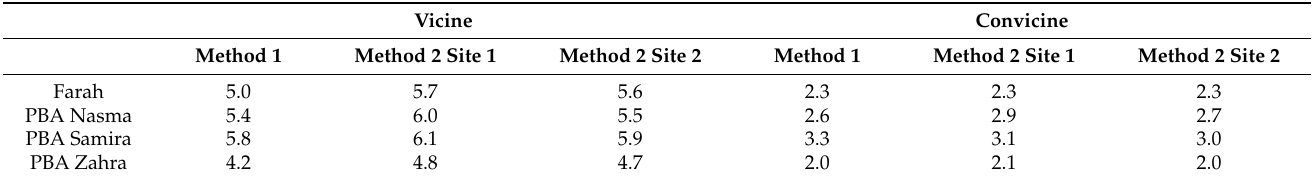
Table 6. Result comparison of four faba bean cultivars grown in different regions determined by two different extraction and analysis